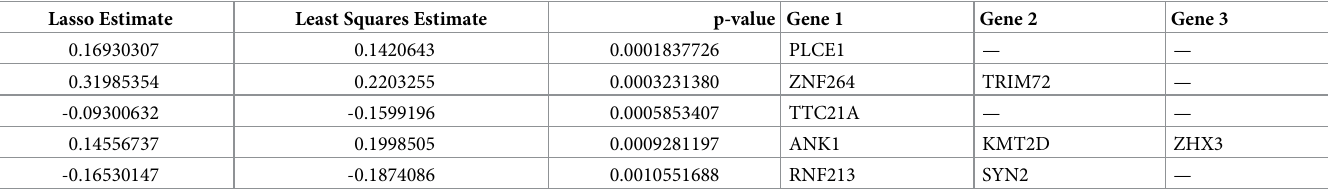
Table 4. InfectX most significant proposed effects. Lasso